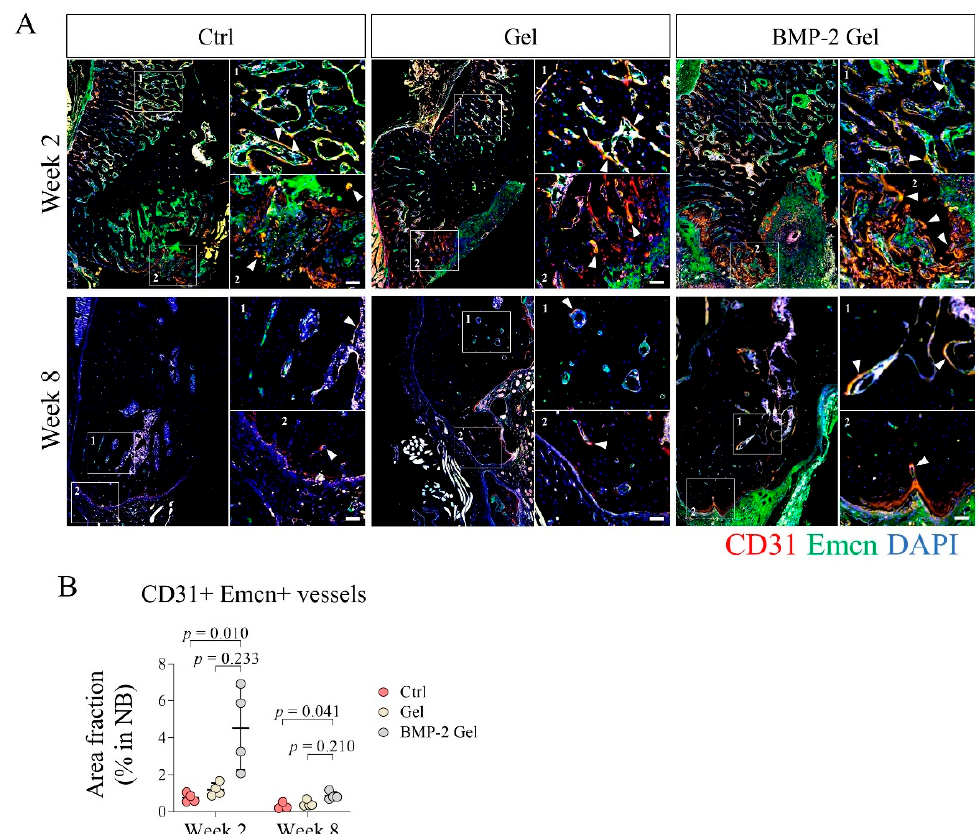
Figure 3. BMP-2 enhanced angiogenesis and growth of type H vessels after implantation during the mandibular defect repair. ( A ) Immunofluorescent staining of type H vessels (CD31+ Emcn+) in the mandibular bone. Scale bar, 50 µ m. The white arrow indicates the type H vessels. ( B ) Quantitative analysis of the area fraction of type H vessels in the new bone. The p value was calculated by one-way ANOVA and Dunn’s multiple comparisons test.